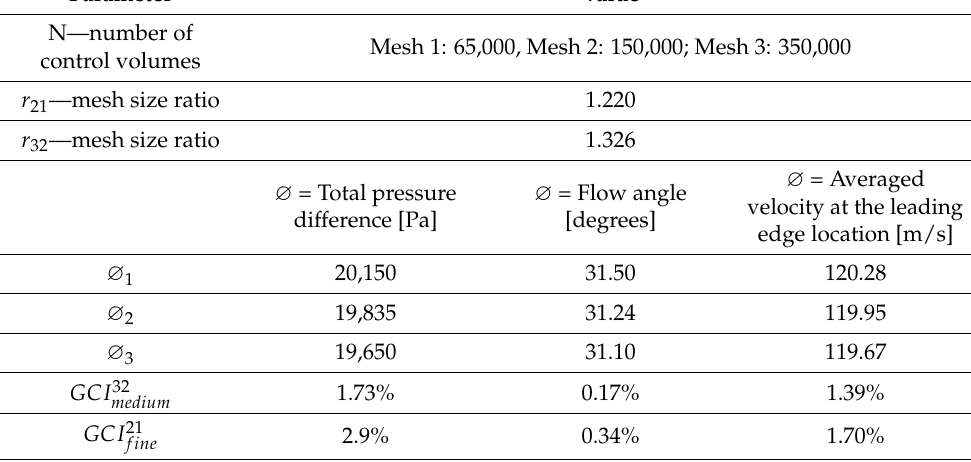
Table 3. Mesh size independence